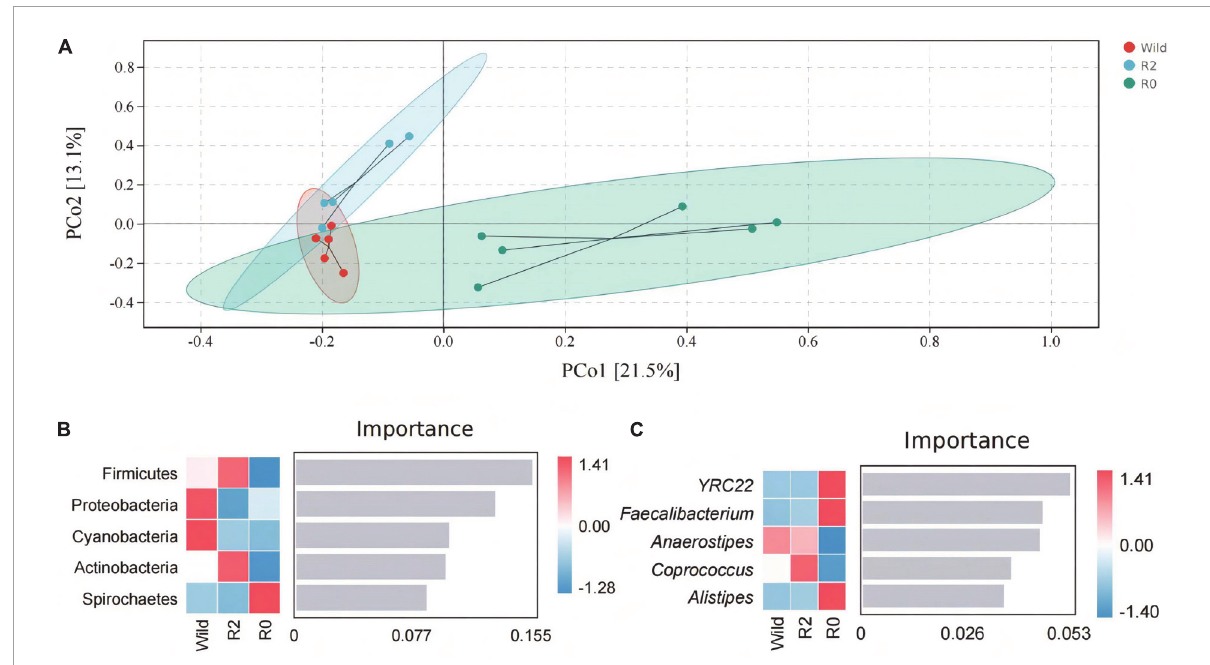
FIGURE4 The gut microbial structure and composition of Wild, R2, and R0 group. (A) A PCoA plot based on Bray-Curtis distance metrics in relation to the whole dataset to describe the microbial structure between different groups. (B) The random forest analysis indicated the target microbial phylum with differences between groups. (C) Target microbial genus with differences.